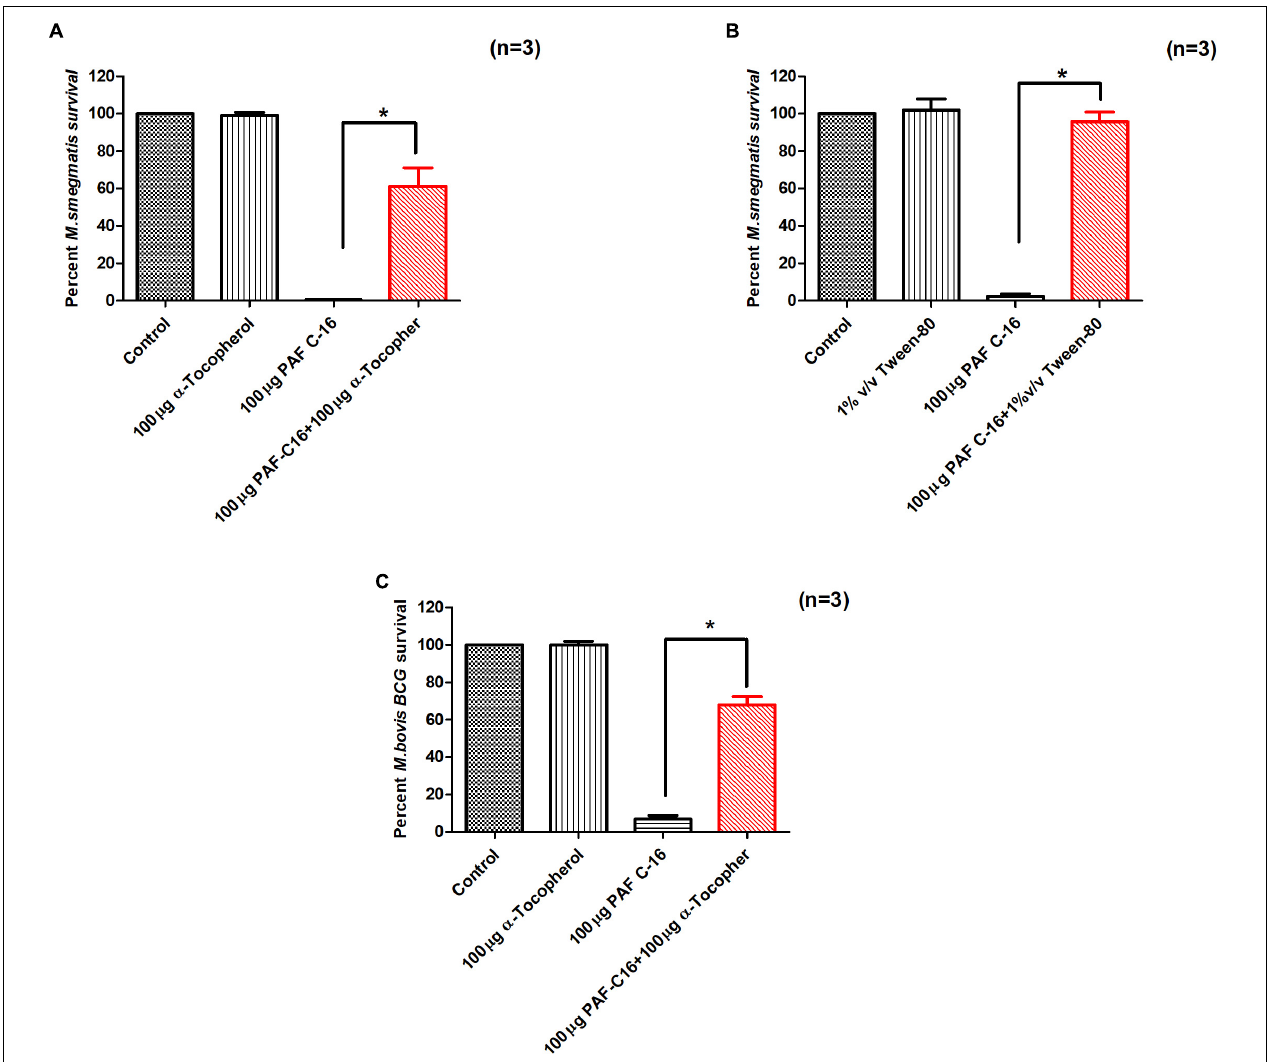
FIGURE 9 | α -Tocopherol and Tween-80 partially mitigate the growth inhibitory effect of PAF C-16 against M. smegmatis and M. bovis BCG. Number of surviving colony forming units of M. smegmatis (A,B) and M. bovis BCG (C) after treatment with the indicated concentrations of α -tocopherol/tween-80 and PAF C-16. The data is expressed as percentage survival where solvent control is taken as 100% survival. Each bar represents the average of three individual experiments performed in triplicate and the error bars show the standard error of mean values ( ± SEM). The p -value was calculated by applying Mann-Whitney test on the given two data sets and was found to be significant ∗ ( p ≤